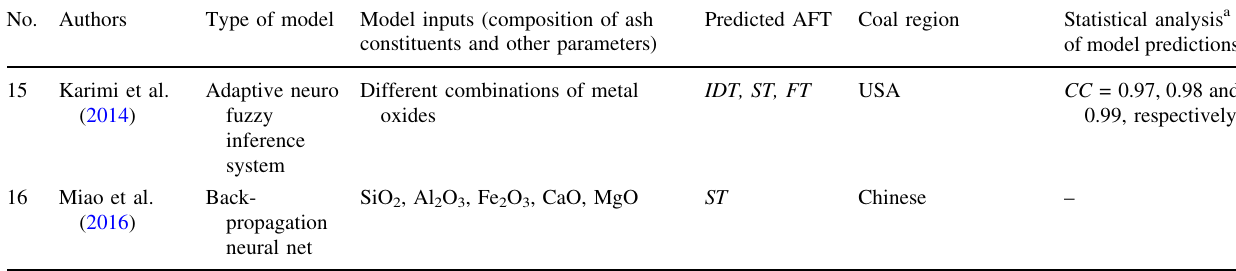
(2) x 2 : weight percentage of Al centage of Fe O , (4) x 4 : weight percentage of CaO, (5) x 5 : 2 3 weight percentage of MgO, (6) x 6 : weight percentage of TiO , and (7) x 7 : weight percentage of K 2